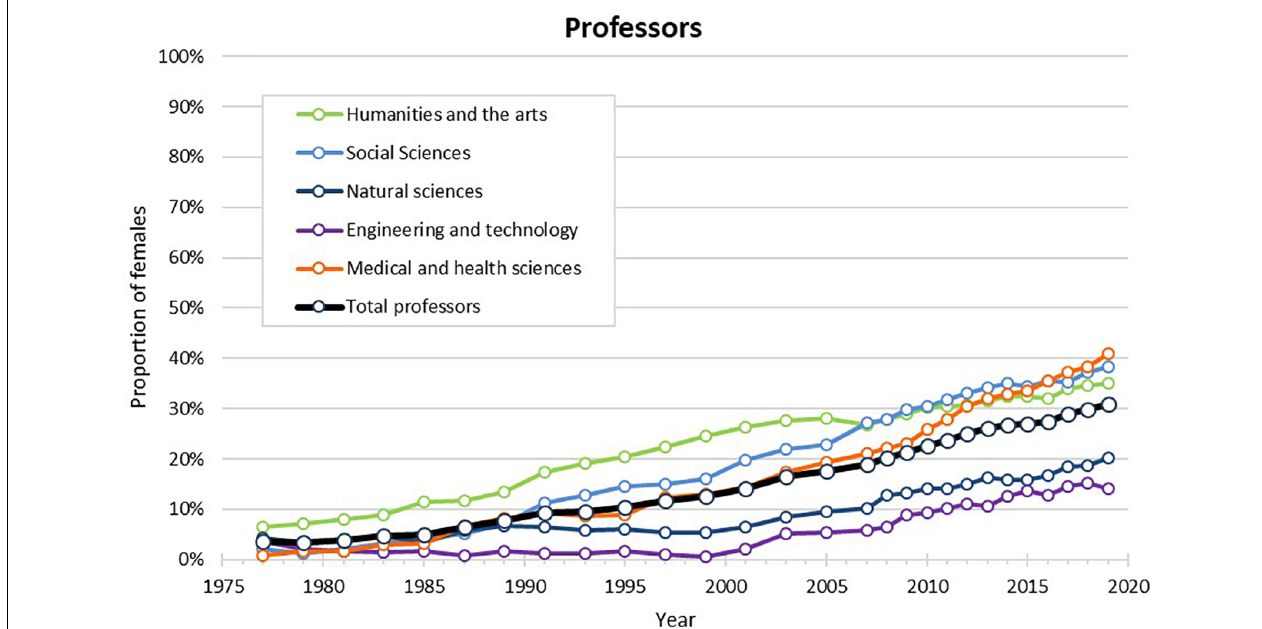
FIGURE 2 | Proportion of female professors at four Norwegian universities 1977–2019.